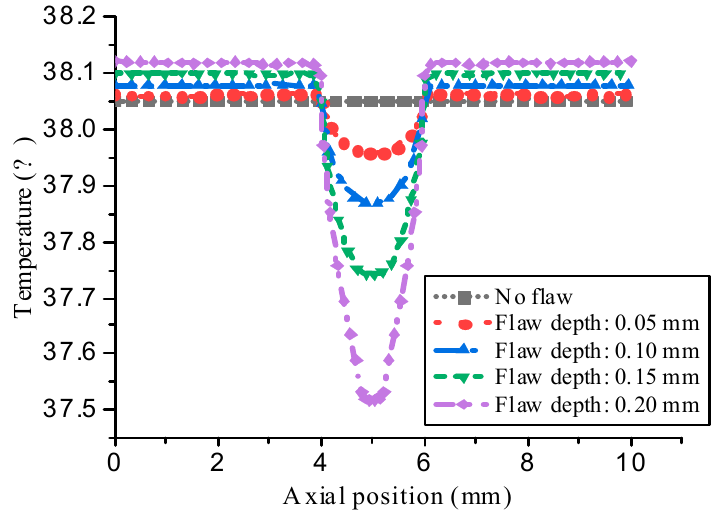
Figure 3. Temperature distribution of the cable surface with different defect depths.